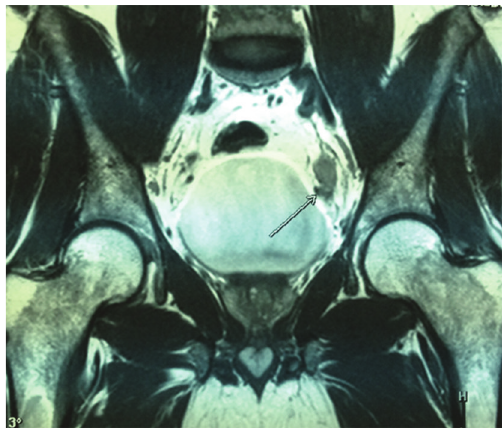
Figure 1: Coronal MR image demonstrating a solid mass located in the left distal ureter.